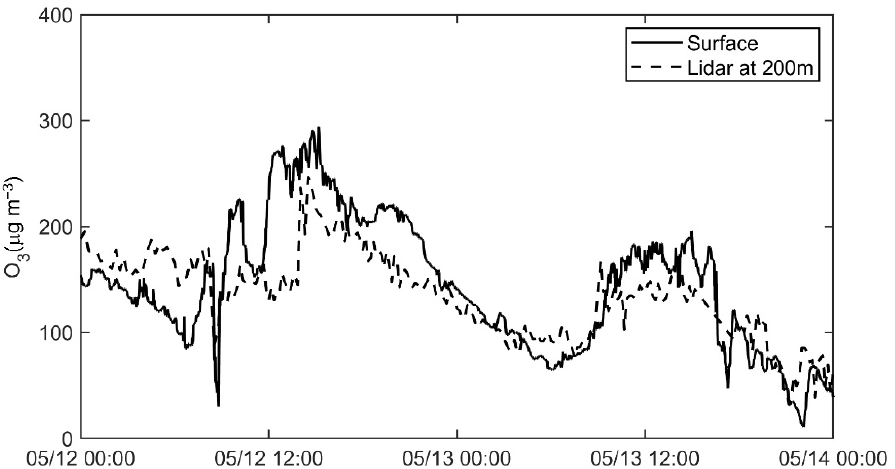
Figure 3. Comparison between the surface ozone concentration obtained by mobile observation vehicle (solid line) and Lidar (dashed line).